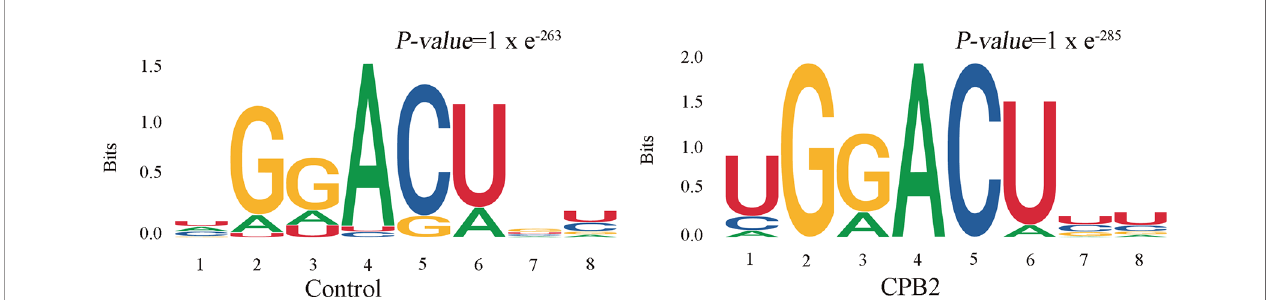
FIGURE 3 | The RRACH conserved sequence motif for m6A peak